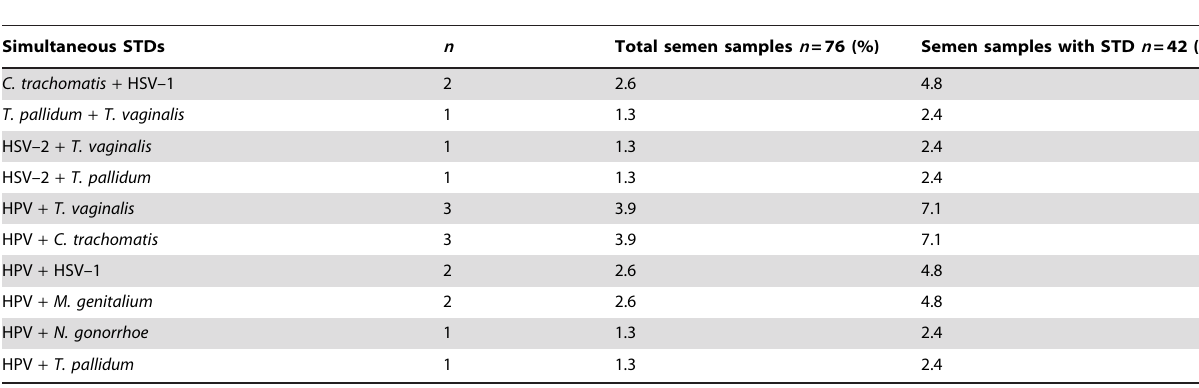
Table 4. Total simultaneous STDs detected by M-PCR and